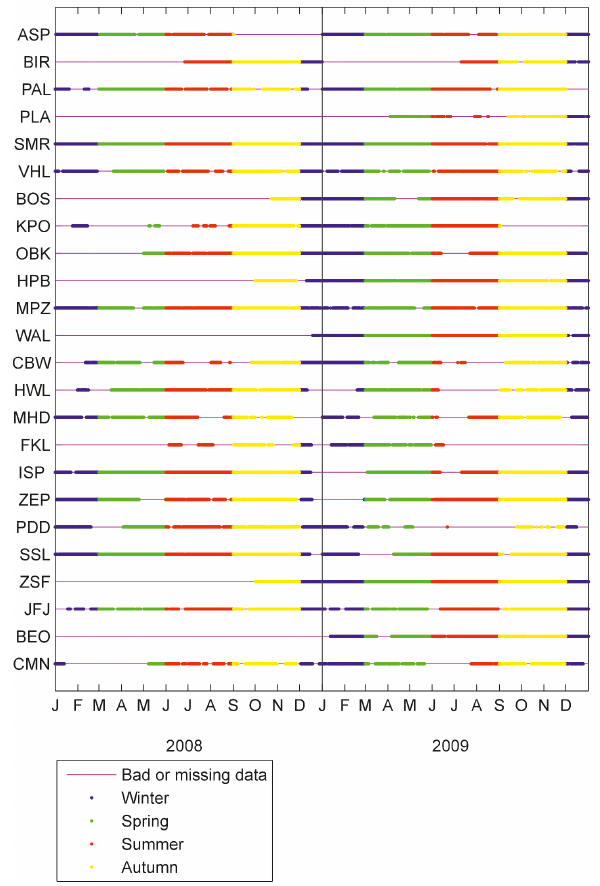
Fig. 3. Data coverage of the stations. Colours indicate the valid data per season. Notable is that all, except one (spring at BIR), of the stations had at least some coverage in all seasons, and most of the stations were operating in both years 2008 and